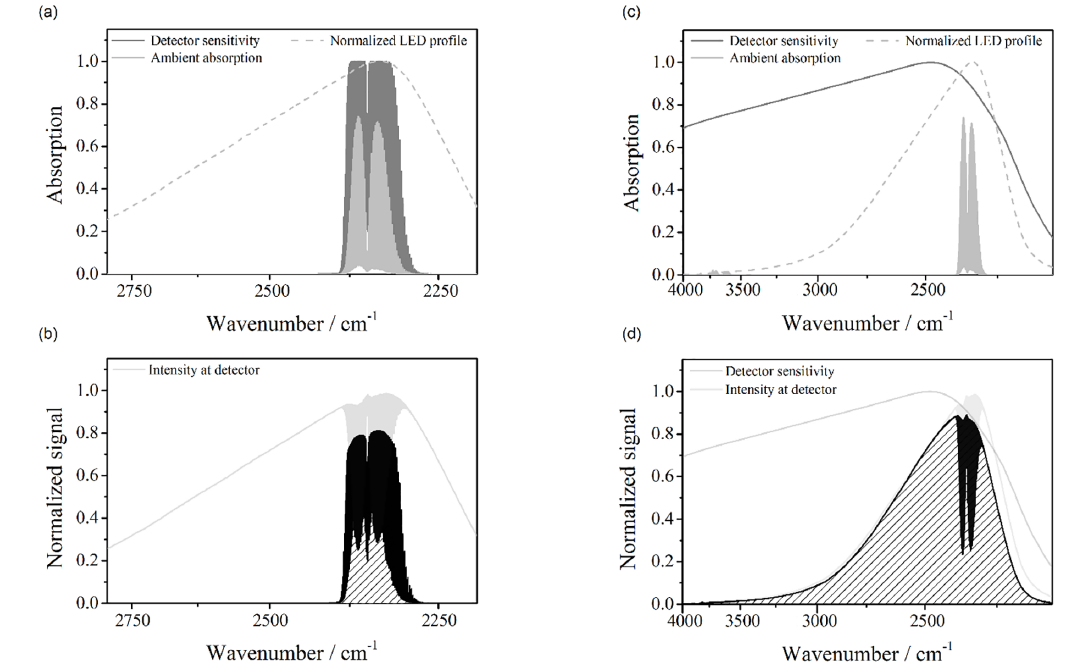
Figure 3. (a) The LED’s emission profile as well as the simulated absorption spectra of the detector filling and the absorption caused by 1000ppm along the optical path of 36mm. (b) The corresponding change in signal strength caused by the absorption is depicted as the black shaded area. (c) The corresponding spectra of a standard NDIR device consisting of the same LED and the same optical path and concentration but using a photodetector to gauge the light intensity. Note the different scale of wavenumbers. (d) The corresponding signal is caused by the same absorption as in the photoacoustic detector, but now the relative change is much smaller.